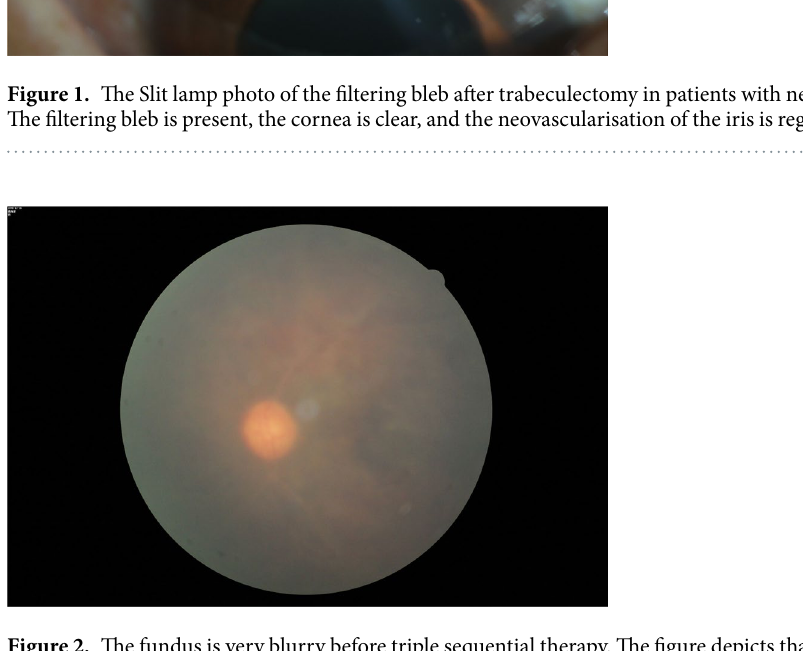
Figure 2. The fundus is very blurry before triple sequential therapy. The figure depicts that viewing of the retinal condition was difficult before treatment due to corneal